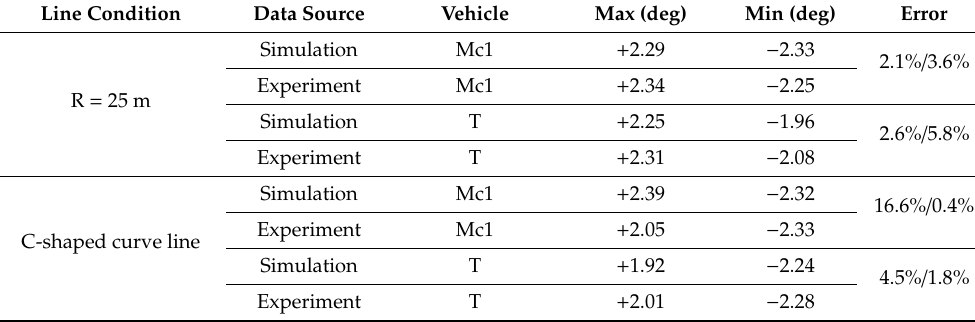
Table 6. Difference between the experimental results and the simulation results, (R = 25 m and C-shaped curve line).